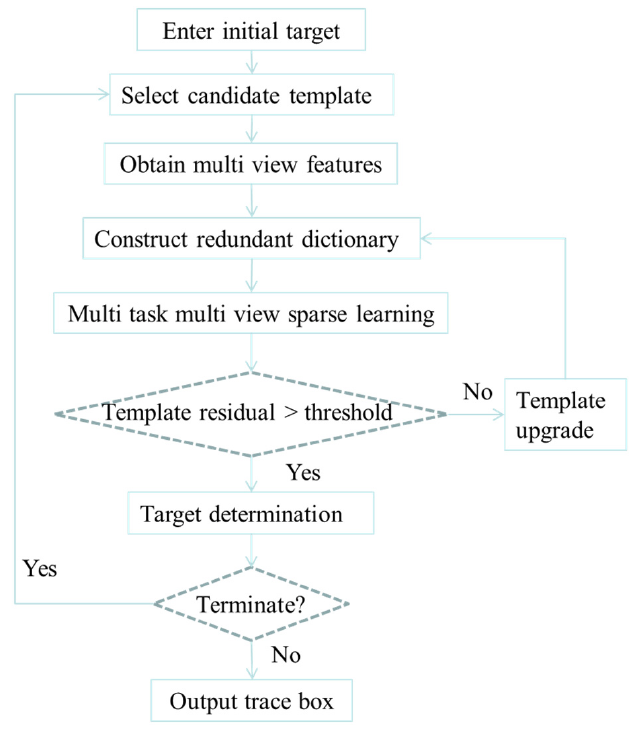
Figure 9. Flow chart of multi ‐ view multi ‐ task target identification